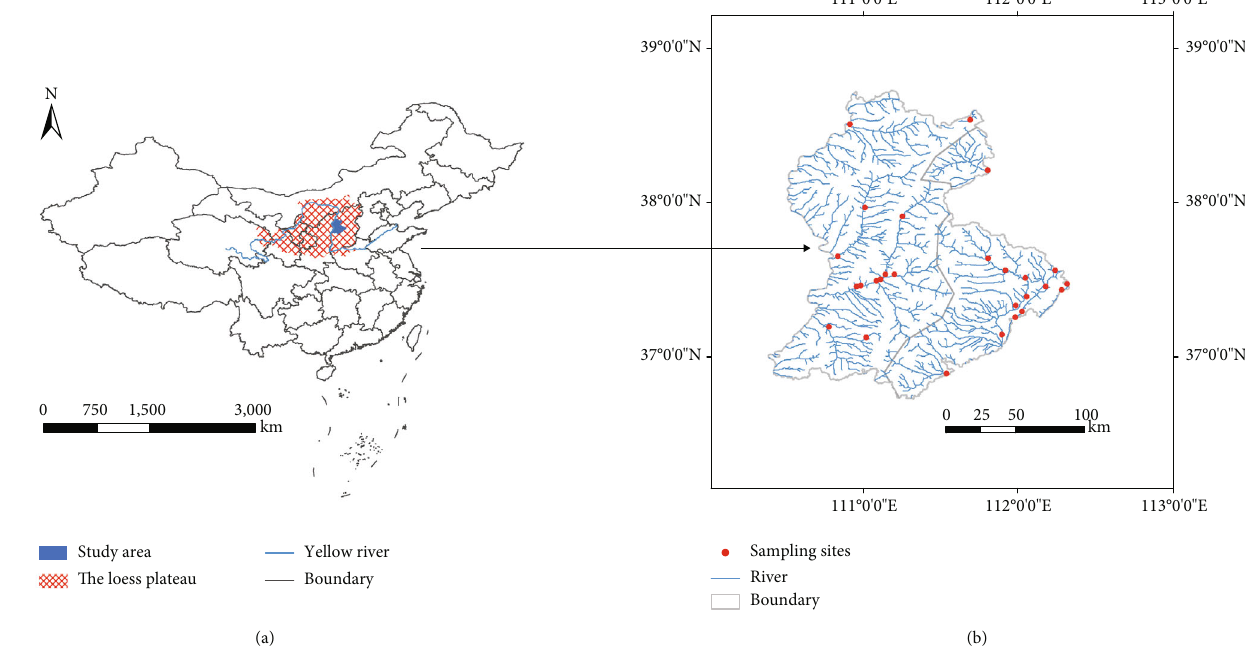
Figure 1: Location of the Loess Plateau, study area, and sampling